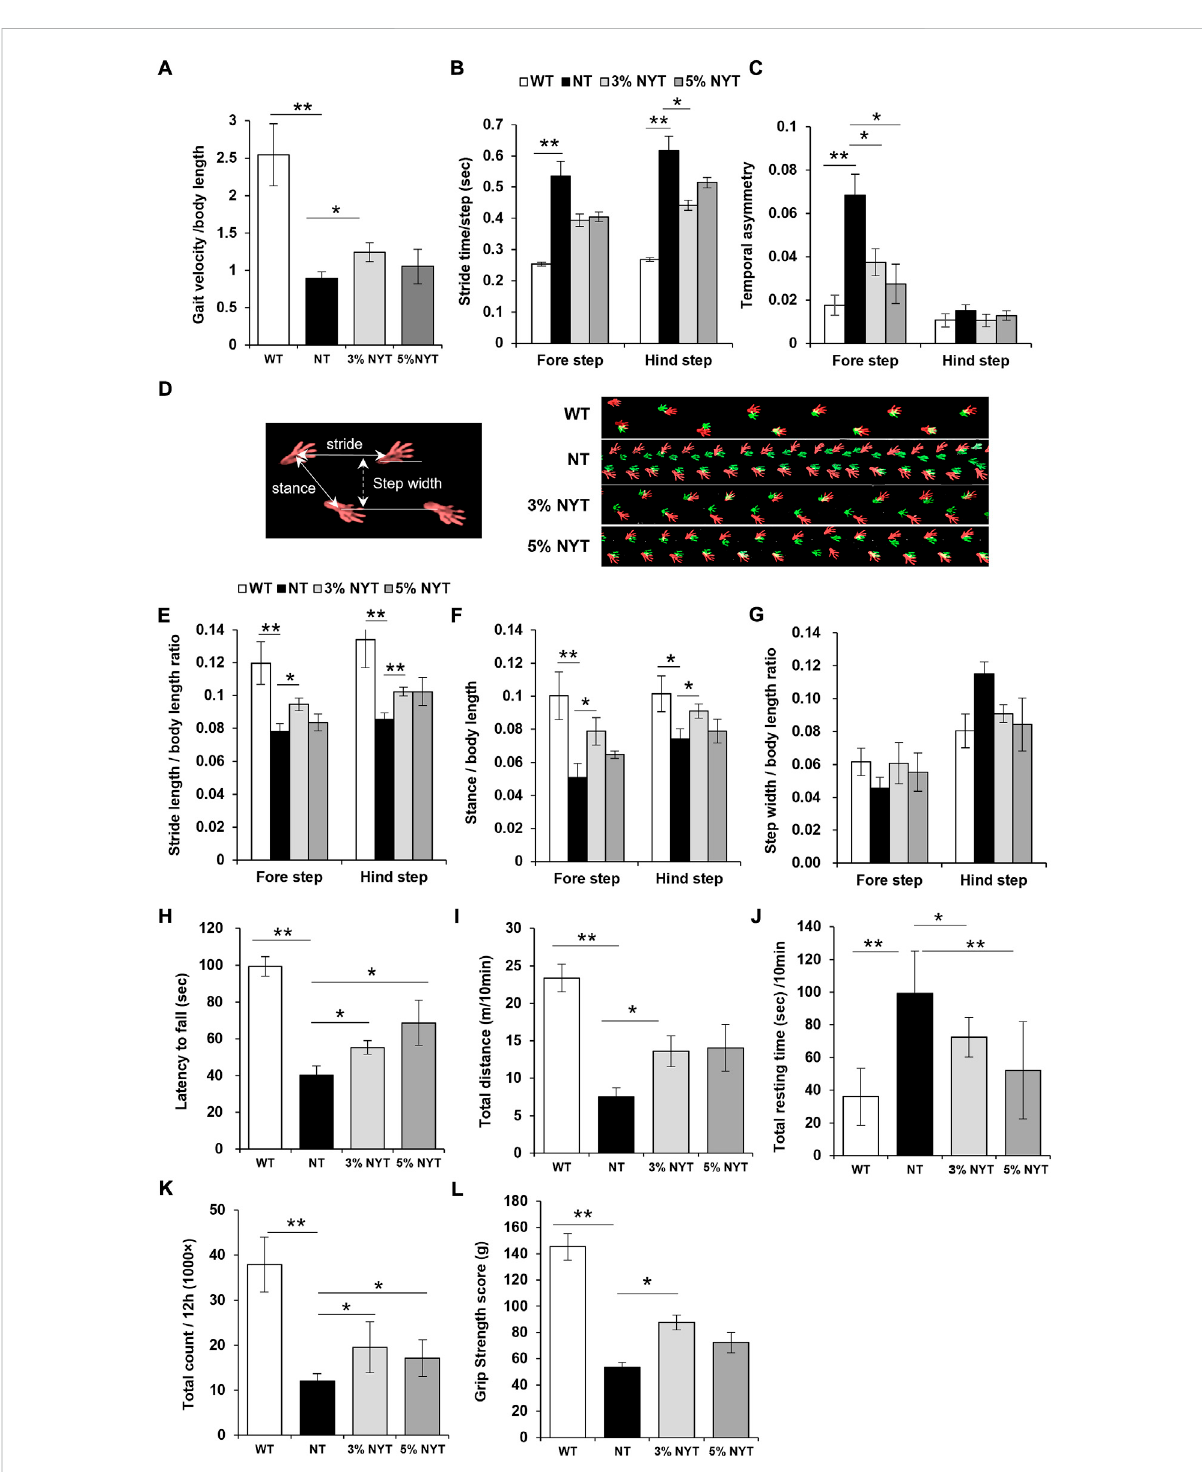
FIGURE 8 EffectsofNYTonimpairmentofphysical performancewithaging. At57 daysofage,miceweresubjectedto